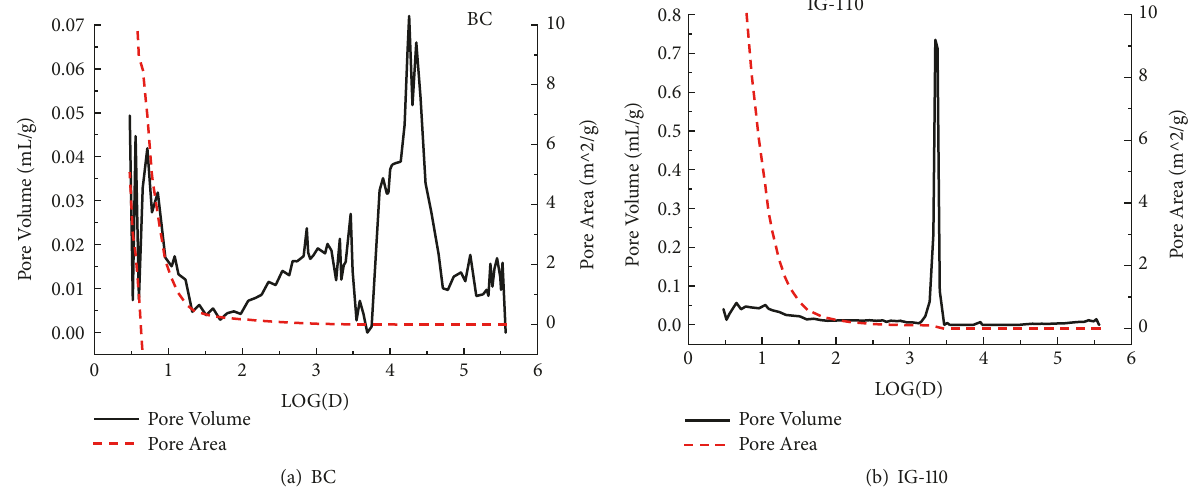
Figure 9: The pore size distribution of BC and IG-110 by HPMI. The abscissa is the logarithm of pore diameter D (nm), the pore area curves of BC and IG-110 is similar, and the pore volume cure of BC has many peaks, while the curve of IG-110 has only one very obvious peak.